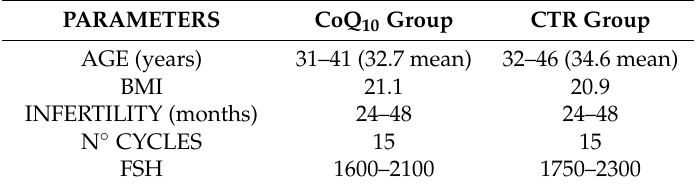
Table 1. Characteristics of patients